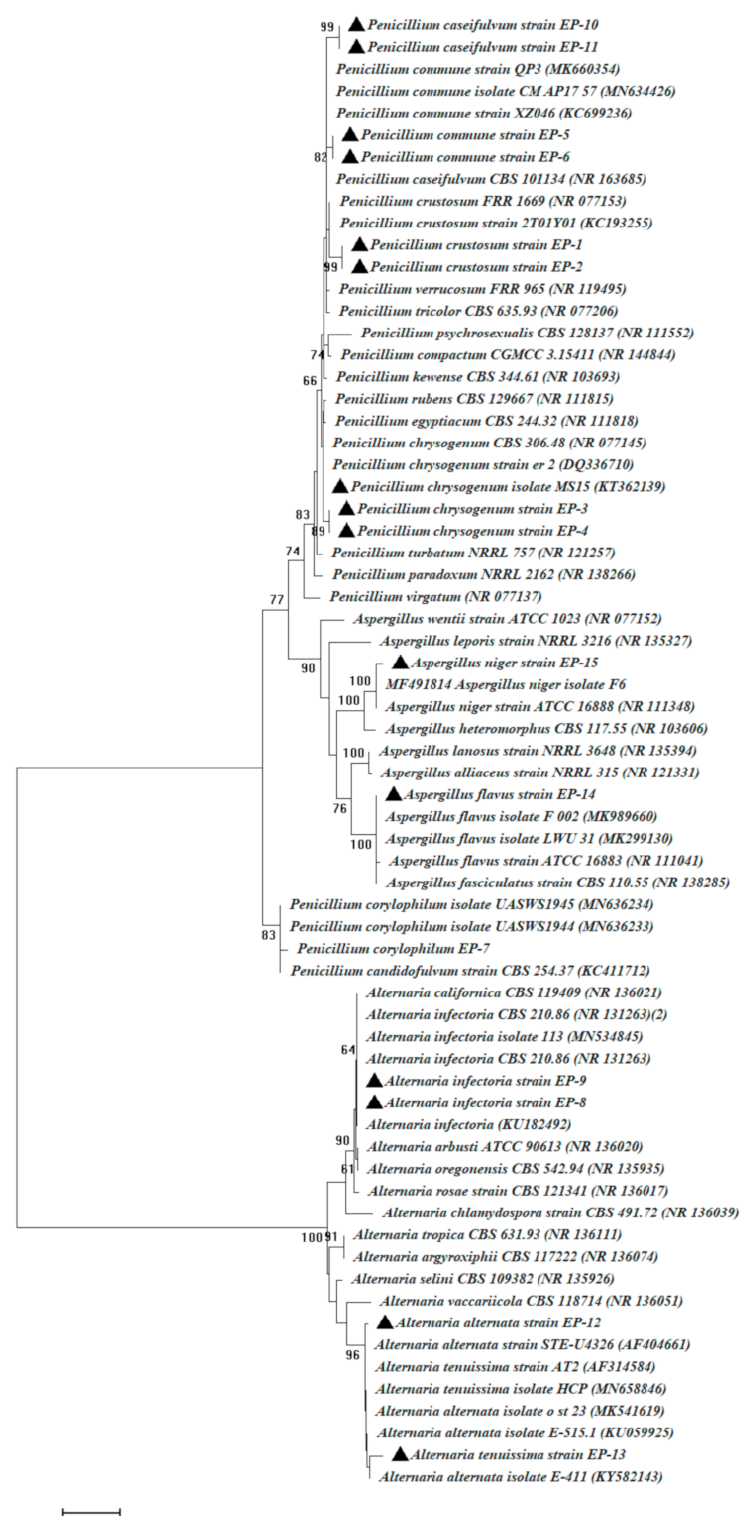
Figure 1. Phylogenetic analysis of ITS sequences of fungal strains with reference sequences retrieved from NCBI (National Center for Biotechnology Information). EP-1–EP-15 refer to the ITS sequences of fungal isolated from Ephedra pachyclada plants. The identity of the fungal isolates is available in Table 1. The analysis was implemented in MEGA 6 using the neighbor-joining